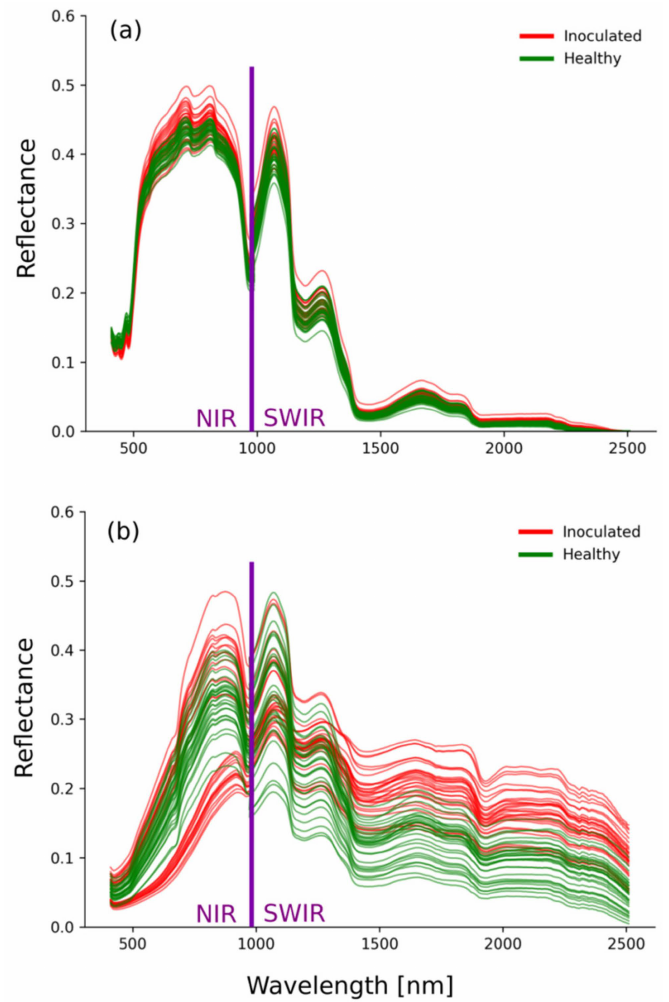
Figure 4. Reflectance feature vectors for ( a ) inside and ( b ) outside of potato tuber. Green colour refers to healthy and red to inoculated specimens. Separation between VNIR and SWIR cameras is marked with violet